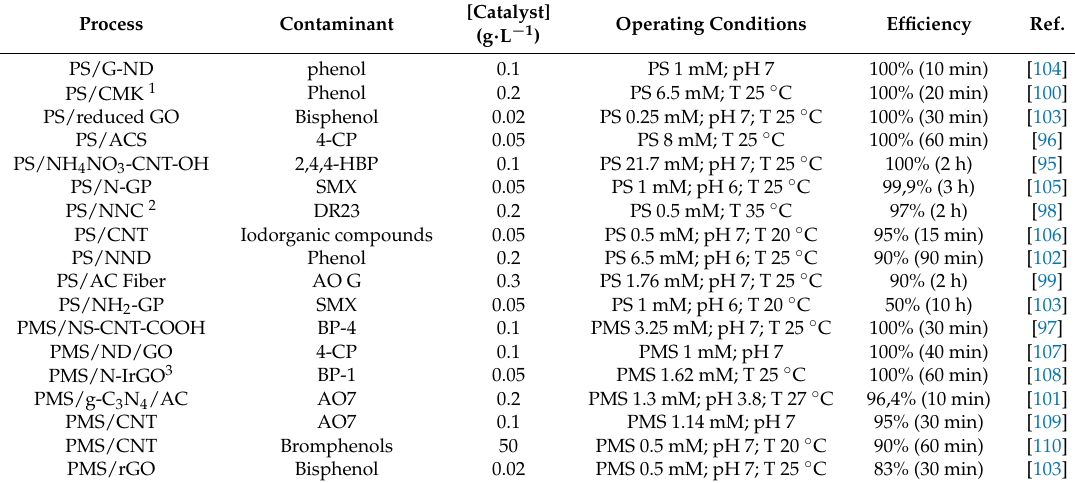
Table 6. PMS and PS activation though carbon-based